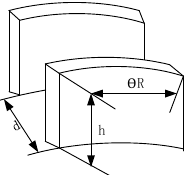
Figure 6. Schematic diagram of an electrostatic drive of parallel plate capacitance.